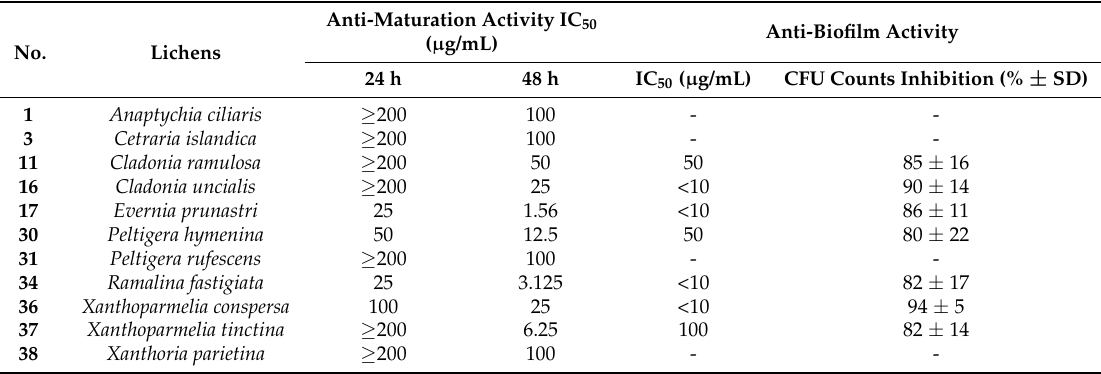
Lichen extracts effective against the maturation phase of Candida albicans biofilms (concentration < 200 µ g/mL at 24 h or 48 h). Kruskal-wallis test: p < 0.03, in duplicate, n = 2; Only extracts having demonstrated an anti-maturation activity (IC 50 _ mat 48 h ≤ 50 µ g/mL) have been selected and tested against pre-formed biofilms with an age of 24 h. This anti-biofilm activity was evaluated after a 48 h incubation, Kruskal-wallis test: p < 0.0002, in sextuplicate n = 2;